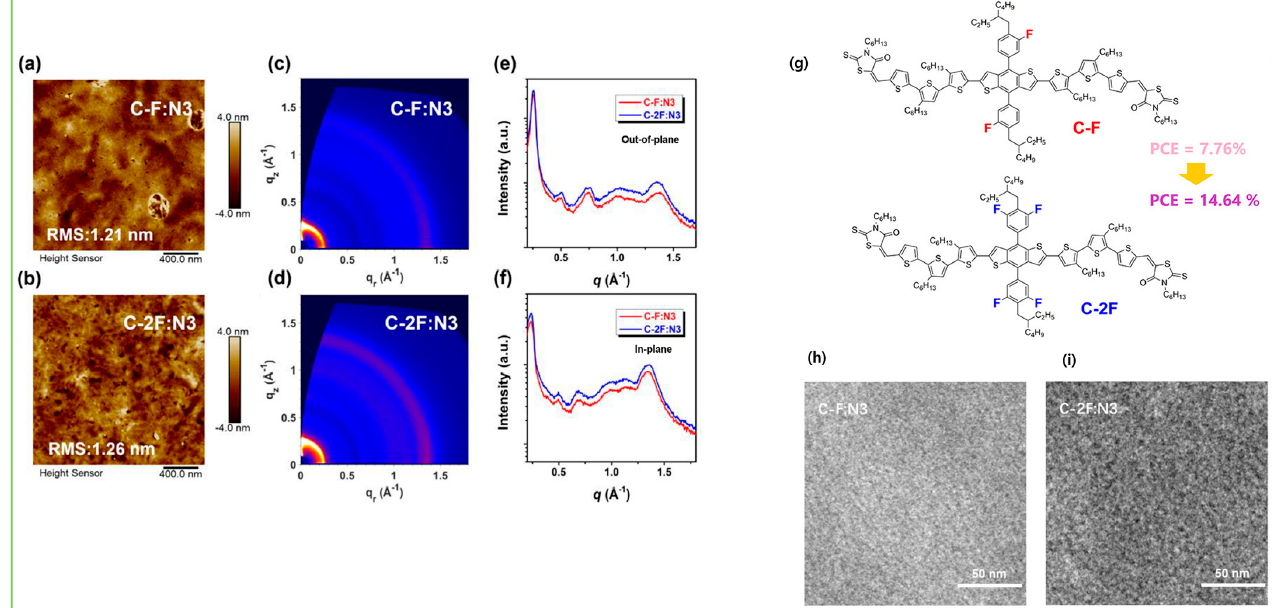
Figure 12. ( a , b ) AFM height images of C − F:N3 and C − 2F:N3 blend films. ( c , d ) GIWAXS two-dimensional diffraction patterns of C − F:N3 and C-2F:N3. ( e , f ) In-plane and out-of-plane line-cut profiles of the two-dimensional GIWAXS data of C-F:N3 and C − 2F:N3 blend films. ( g ) Chemical structures of C − F and C − 2F. ( h , i ) TEM images of C − F: N3 and C − 2F: N3 blend films, respectively. Adapted with permission from [49]. Copyright 2022, American Chemical Society.